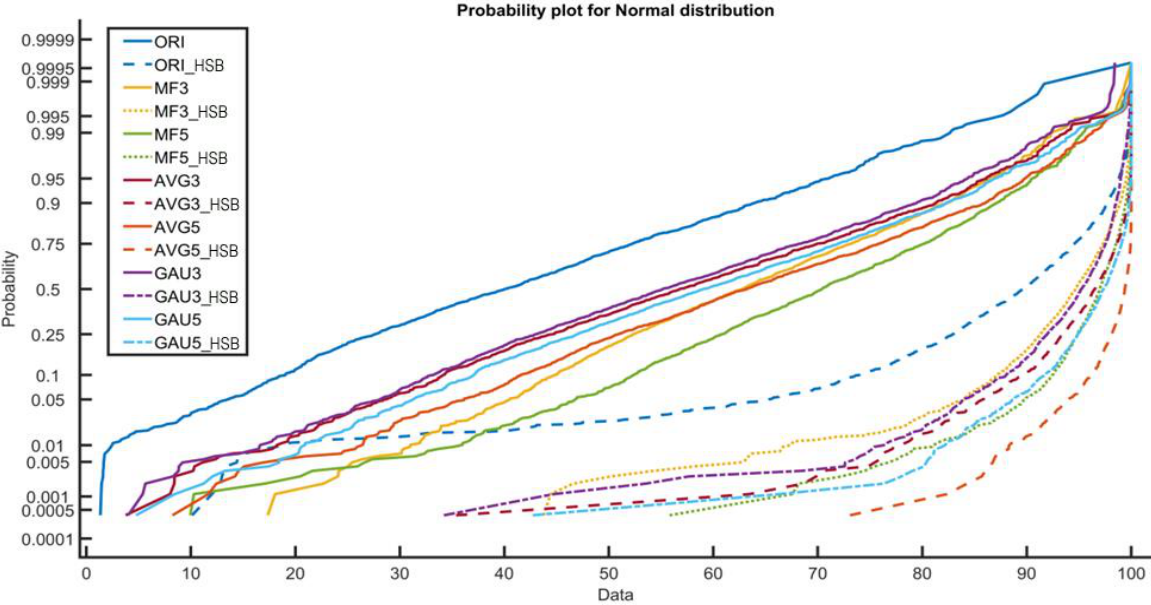
Figure 2. Normal distribution of 8-bit and 4-bit images.